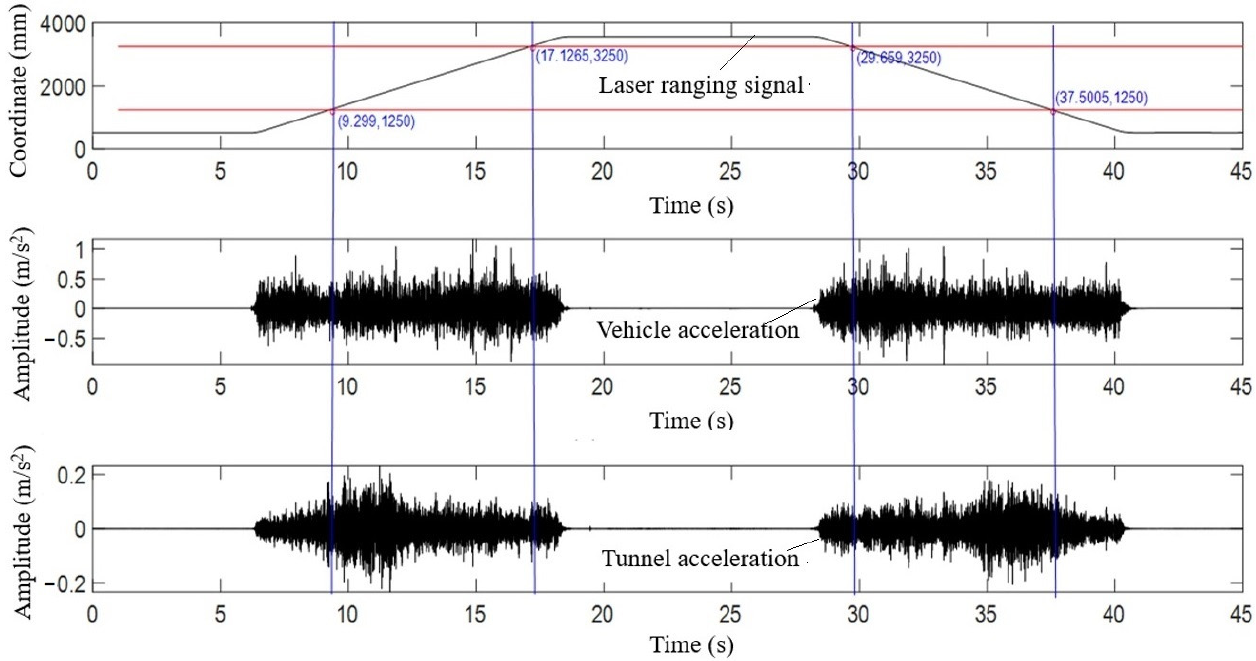
Figure 14. The interception of the original signal in synchronous acquisition.